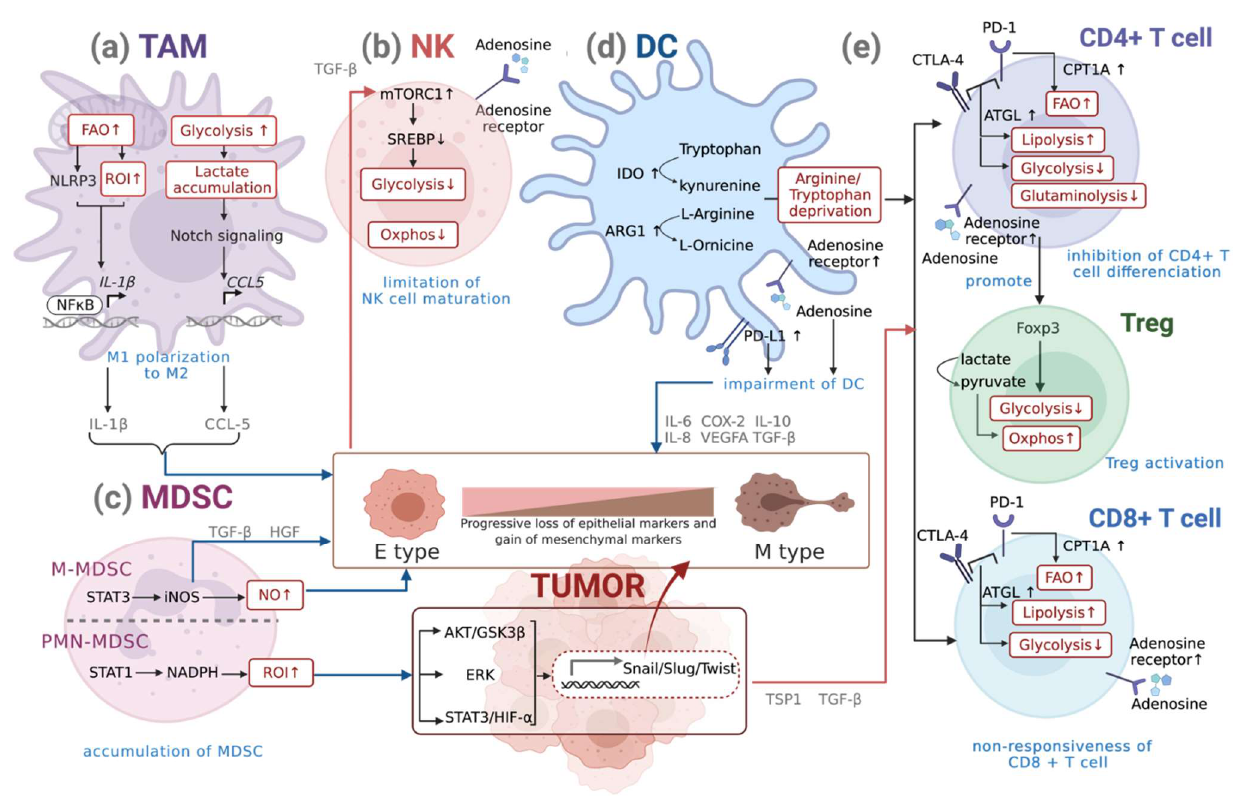
Figure 2. Interplay of metabolic reprogramming of immune cells and EMT. ( a ) Although expressing M2 markers, the metabolism of EMT-associated TAMs is distinct from conventional M2 polarized subset, as they prioritize glycolysis instead of OXPHOS; these TAMs also depend on FAO. ( b ) In NK cells, mTORC1 inhibition downregulates Srebp activity to decrease glycolysis and OXPHOS. ( c ) PMN-MDSCs mainly produce ROI to trigger the activation of signaling pathways such as STAT3/HIF-1α, ERK, and AKT/GSK3β, promoting several EMT-TF expressions, including Snail Slug and Twist1; M-MDSCs can also generate NO to promote EMT. ( d ) In DCs, EMT-induced high expression of IDO and ARG1 leads to depletion of arginine and tryptophan in the TME, which inhibits CD4+ proliferation and causes CD8+ T cell non-responsiveness; higher expression of PD-L1 and adenosine receptor on the cell surface impairs the function of DCs. ( e ) Via the checkpoint blockade of signaling molecules PD-1 and CTLA4 signaling, activated CD4+ and CD8+ T cells reduce glycolysis while promoting FAO and lipolysis; the downregulation of glutaminolysis alters CD4 differentiation and promotes the development of Treg cells. Being capable of converting lactate into pyruvate and supporting OXPHOS effectively, Treg cells resist lactate-mediated suppression of cell function and proliferation in the TME. Similar to NKs and DCs, higher expression of adenosine receptor on the surface of T cells suppresses the function of effector T cells. Red arrows indicate how the process of EMT can affect immunometabolism; blue arrows demonstrate how metabolic reprogramming alters immune cell function to further assist EMT. Created with BioRender.com (accessed on 18 August 2021).